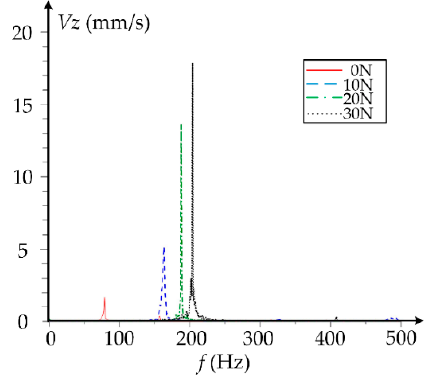
Figure 7. The bearing vibration under different radial loads when L = 1.3.